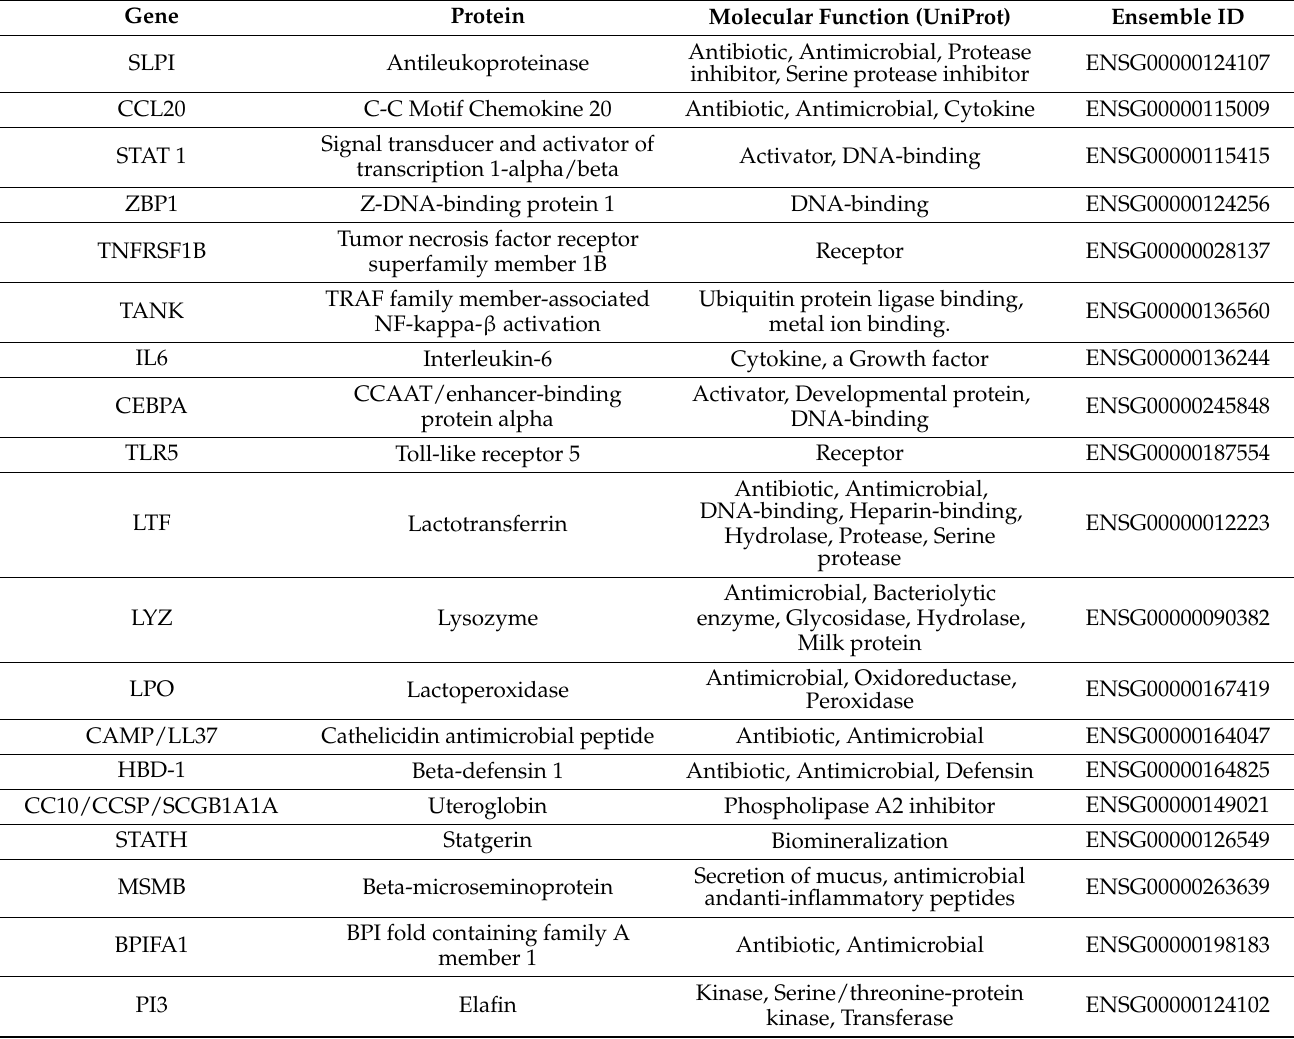
Table 2. AMP genes, which are used in gene expression